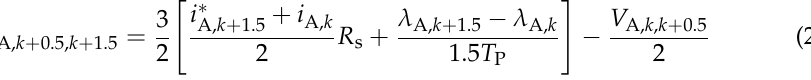
Figure 11. The baseline current detection scheme with two multiplexed hall effect sensors for the four-phase SRM.